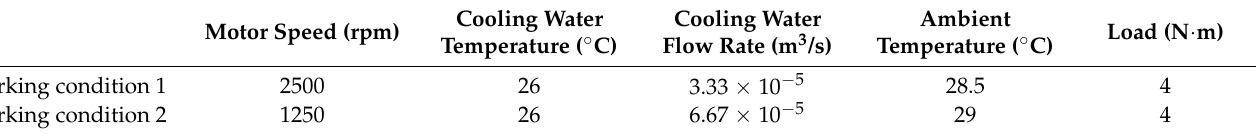
Table 6. Comparison table of working condition